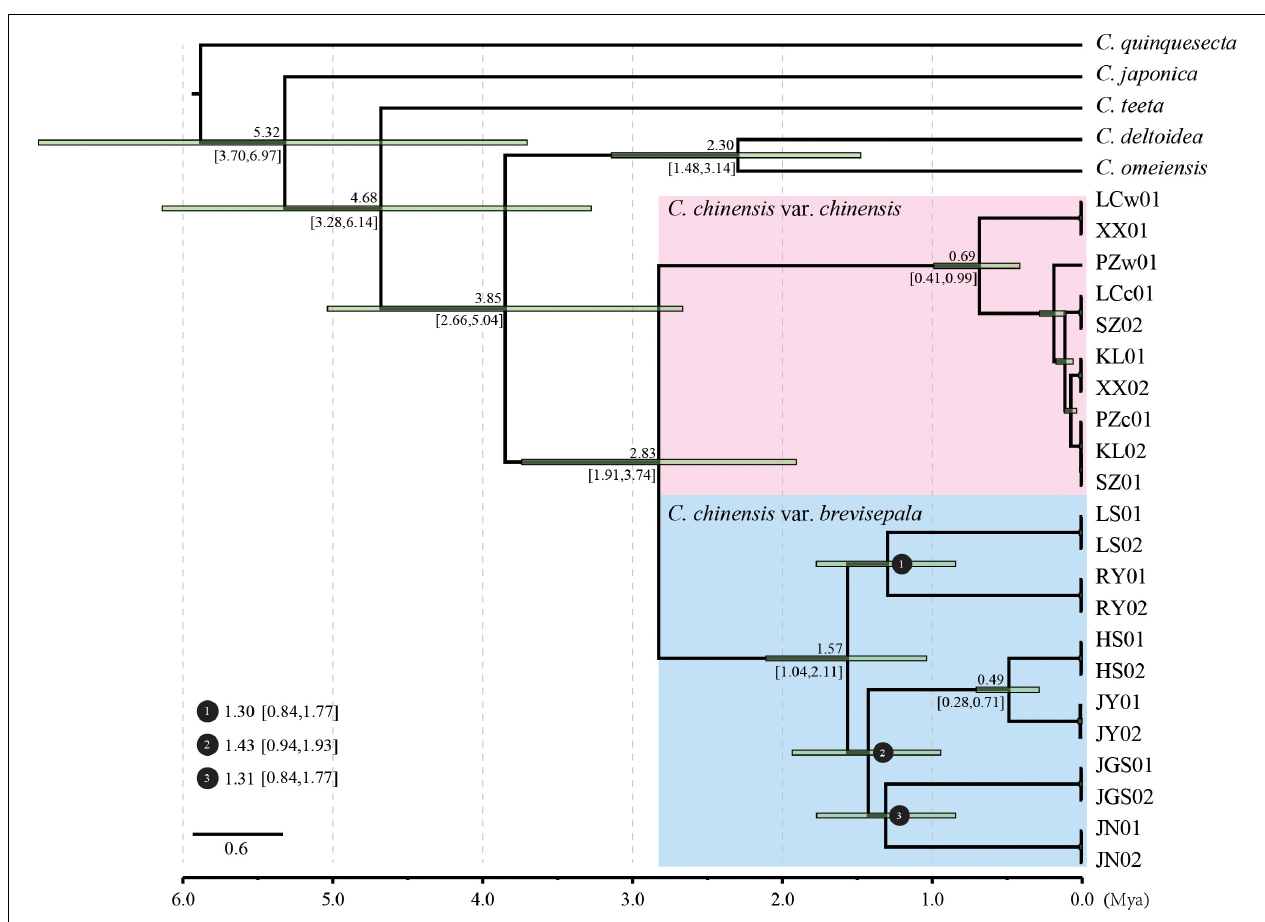
FIGURE 3 | Divergence time estimation based on the plastids of Coptis . Numbers above and under the branches indicate the mean divergence times and 95% confidence interval of each node, respectively. Green bars indicate the 95% highest posterior density intervals. Divergence time and the timeline are indicated in million years ago